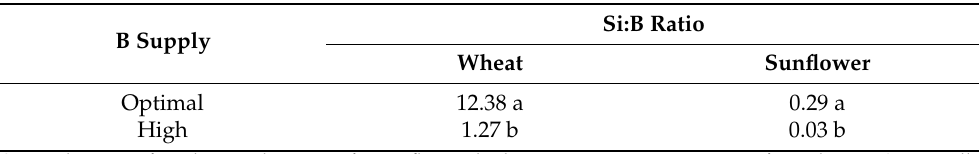
Table 3. Relative proportion of Si and B in the cell wall material from the youngest fully expanded leaves of wheat and sunflower grown at 1.5 mM Si.